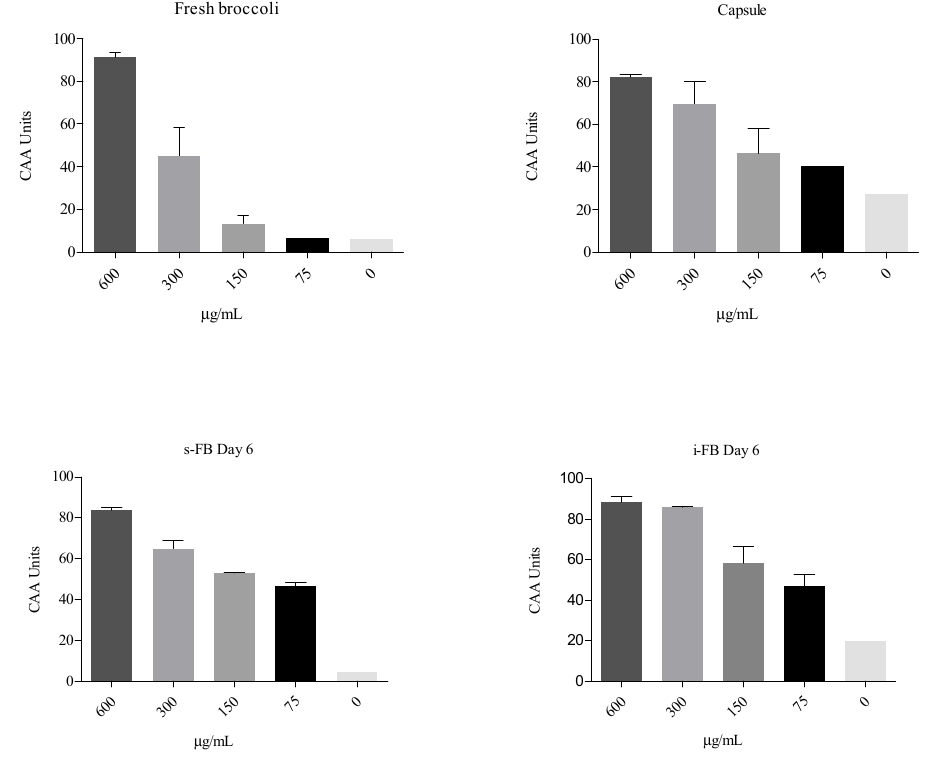
Figure 5. Cellular antioxidant activity (CAA) assay of fresh broccoli (upper-left corner), a commercial capsule of indole-3-carbinol with cruciferous vegetables (100 mg, Solaray ® ) (upper right), and spontaneous (lower-left corner) or induced fermented broccoli (lower-right corner) extracts in Caco2 cells.